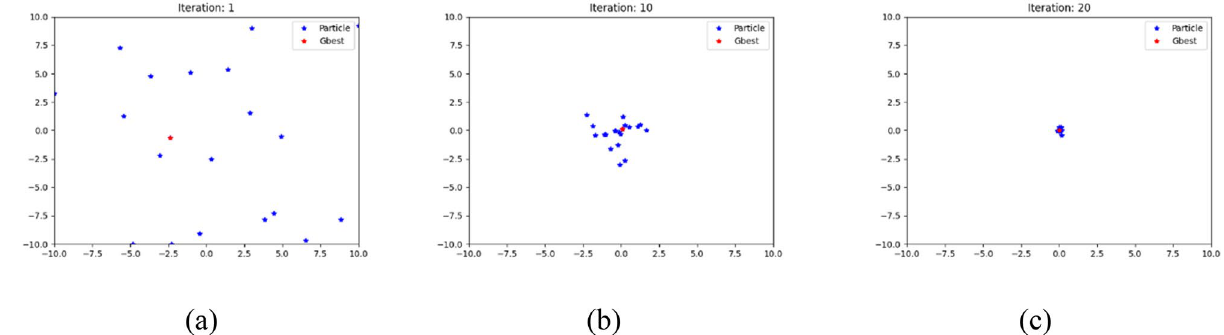
Figure 1. Distribution of 20 agents in AEFA with ( a ) the random distribution of agents, ( b ) the updated locations of agents after 10 iterations and ( c ) the gathered positions of